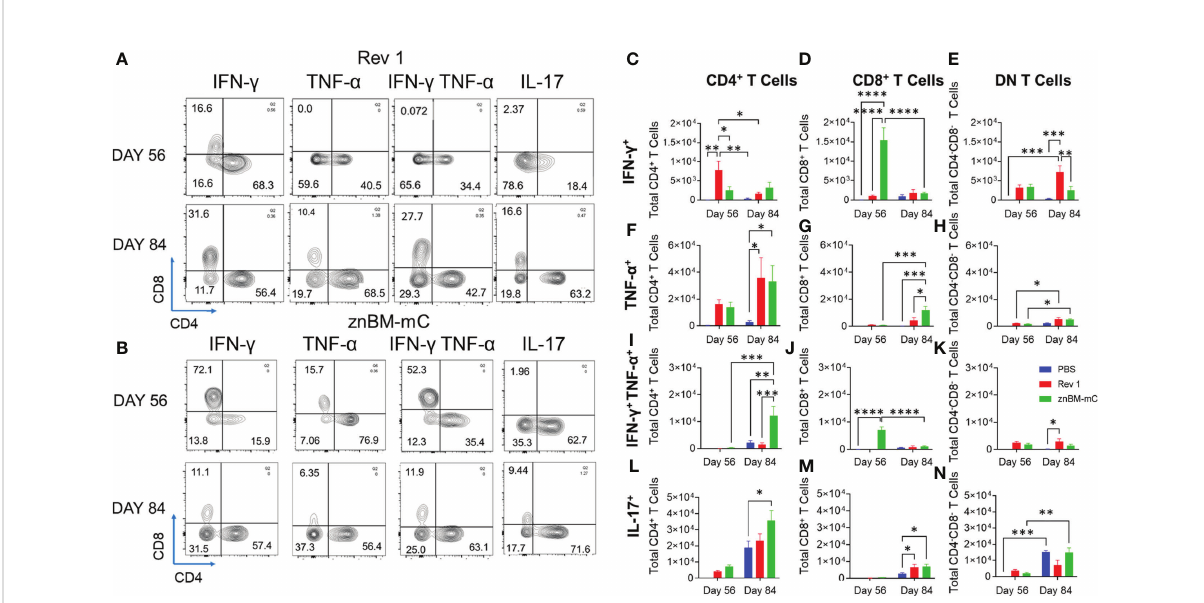
FIGURE 7 Mucosal vaccination with znBM-mC enhances cytokine production by lung CD4 + and CD8 + T cells. Groups offemale BALB/c mice (10 – 14 mice/group) were vaccinated using the previously established protocol, and half the mice were subjected to pulmonary challenge with wt B. melitensis 16M as previously described. Pre- (day 56) and post-challenge (day 84) lung lymphocytes were isolated and restimulated overnight with the equivalent of 10 9 CFUs/ml of Brucella Ag. Surface and intracellular staining were performed to measure the cytokine response. (A) Representative FACS plots show distribution of cytokines produced upon gating on cytokine + TCR b + cells from Rev 1-vaccinated mice into CD4 + and CD8 + T cells on day 56 (top row) and day 84 (bottom row). (B) Representative FACS plots show distribution of cytokines produced upon gating on cytokine + TCR b + cells from znBM- mC-vaccinated mice into CD4 + and CD8 + T cells on day 56 (top row) and day 84 (bottom row). Total numbers of cells producing IFN- g for (C) CD4 + (D) CD8 + and (E) CD4 − CD8 − (double-negative; DN) T cells are depicted. Total numbers of TNF- a − producing (F) CD4 + , (G) CD8 + , and (H) DN T cells are shown. Total numbers of IFN- g + TNF- a + (I) CD4 + , (J) CD8 + , and (K) DN T cells are depicted. Total numbers of IL-17-producing (L) CD4 + , (M) CD8 + , and (N) DN T cells are shown. The data depict the sum of two experiments, and two-way analysis of variance followed by Tukey ’ s multiple comparisons test was performed; *p <0.05, **p <0.005, ***p <0.0005, ****p <0.0001 vs. PBS-dosed